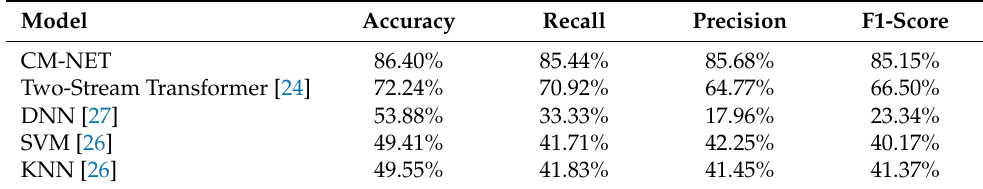
Table 3. Performance of existing networks on dataset-1.